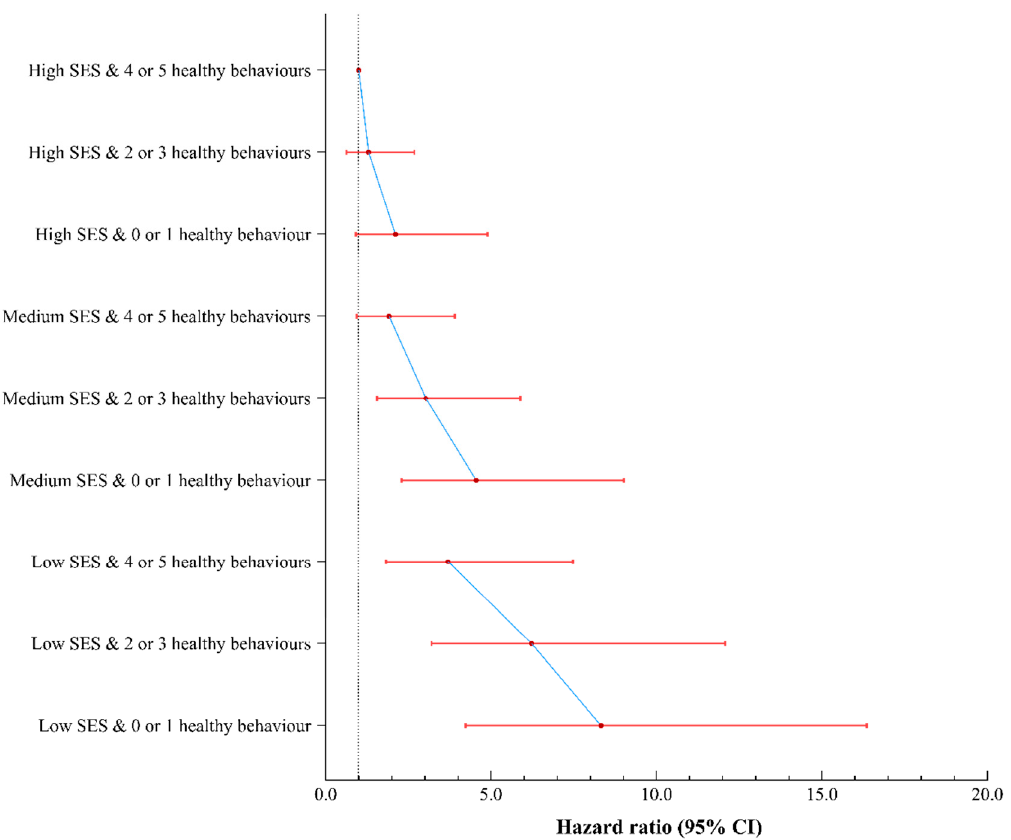
Figure 2. Joint associations of healthy behaviors and socioeconomic status with total respiratory disease mortality. Models all adjusted for age, gender, race and ethnicity, general health, weight loss, diabetes, cardiovascular disease, cancer, family history, poor psychological status, sleep duration, coffee intake, and consumption of tea. 95% CI = 95% confidence interval. SES = socioeconomic status.